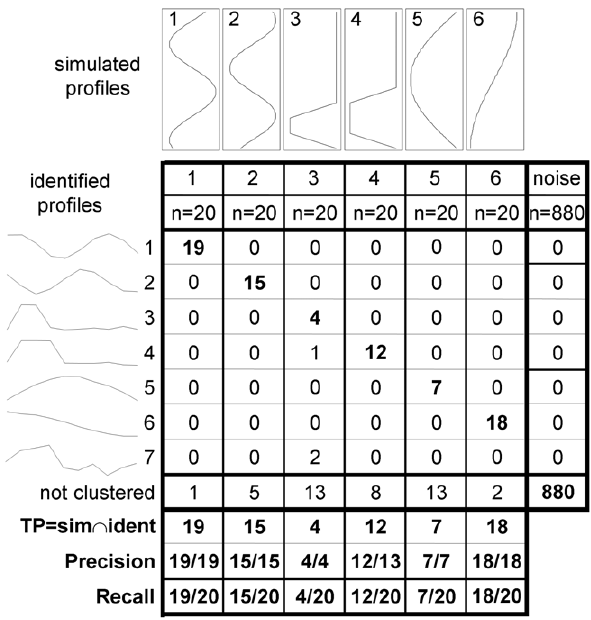
Figure 1. Temporal patterns used to simulate the data (columns) and identified by the method (rows) for a specific simulated data set. 100 data sets of 1000 genes monitored on 13 time samples were simulated. Each data set, like the one shown in this figure, consists of 120 differentially expressed genes separated in 6 clusters characterized by different temporal patterns and 880 not differentially expressed profiles. The number of genes in the intersection between a simulated and an identified cluster is indicated; the maximum of these numbers for each simulated cluster is assumed as the number of true positives. For each column, precision is calculated as true positives divided by the number of genes identified in the cluster; recall as true positives divided by the number of genes in the simulated cluster.